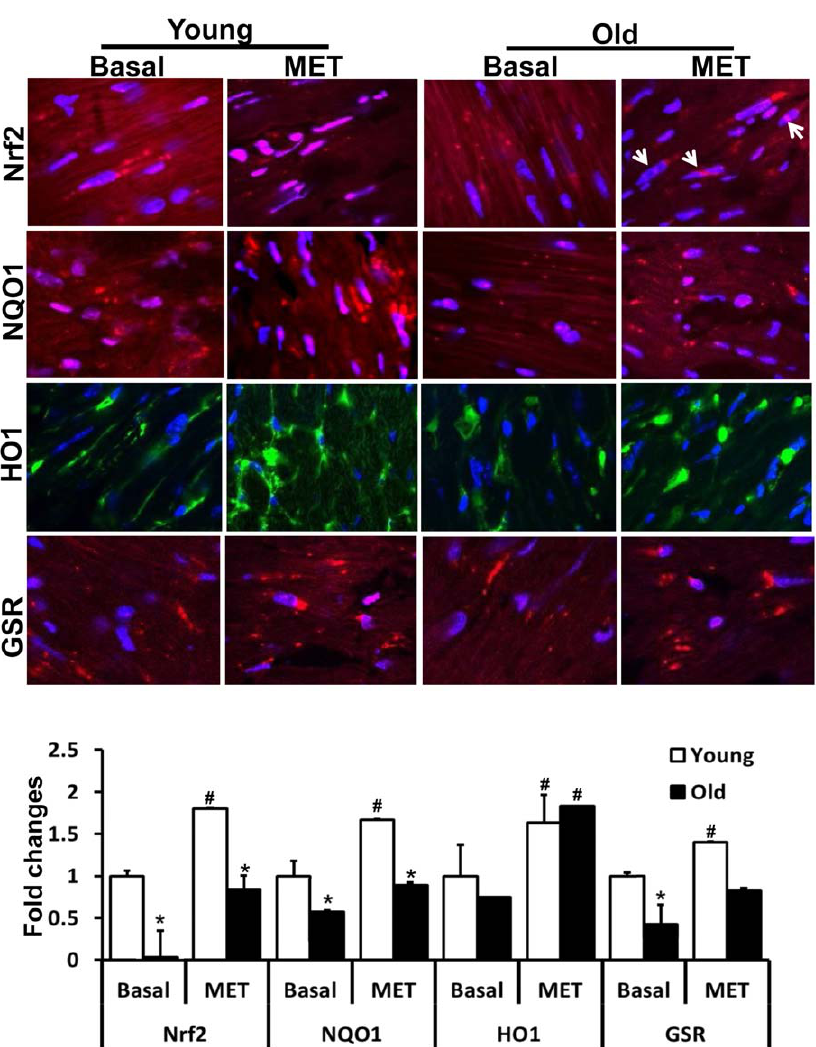
Figure 7. Exercise training induced Nrf2 nuclear translocation and increased antioxidant levels. Immunofluorescence (IF) analysis using anti-Nrf2-ab (1:200; v/v) showing nuclear translocation of Nrf2 in the hearts of young and old after MET (panel 1). Blue: nucleus (DAPI); Red: Nrf2- staining and Pink: merge of blue and red indicating nuclear localization of Nrf2. Panels 2–4 depict the expression of NQO1 (1:400), HO1 (1:150) and GSR (1:200) in the cardiomyocytes of young and old mice after MET. The levels of these antioxidants were comparable in the cytosol of young and old (*p , 0.05) cardiomyocytes after 6-weeks of exercise training. # p , 0.05 between basal and MET. IF images were obtained at 60X magnification.